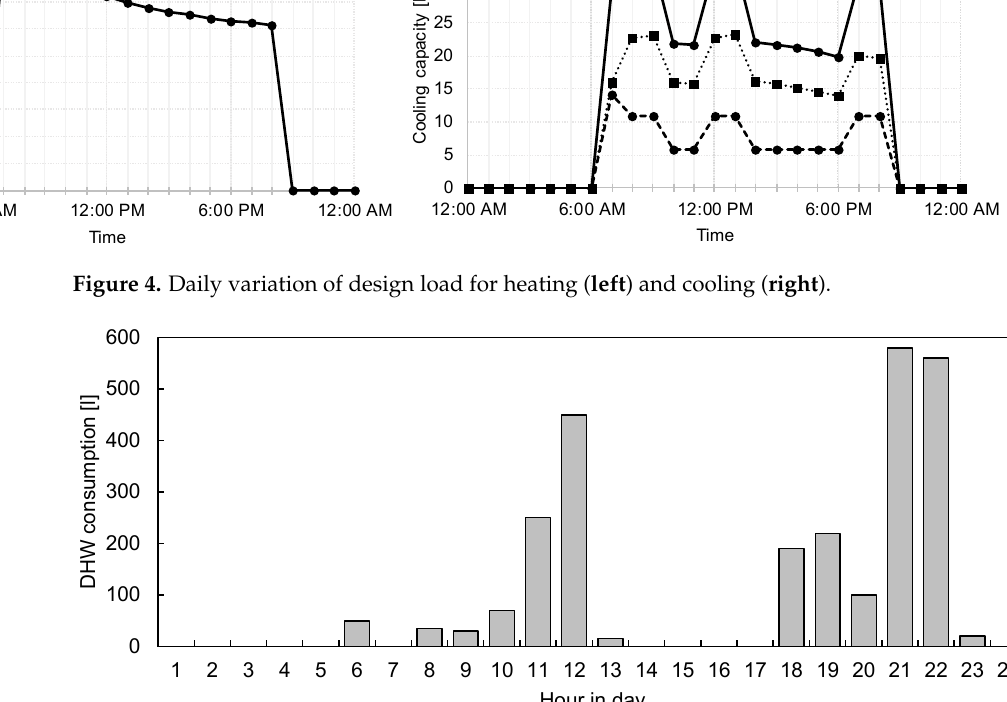
Table 2. HVAC systems considered in the analysis. Figure 5. DHW consumption profile for a standard day in a year.